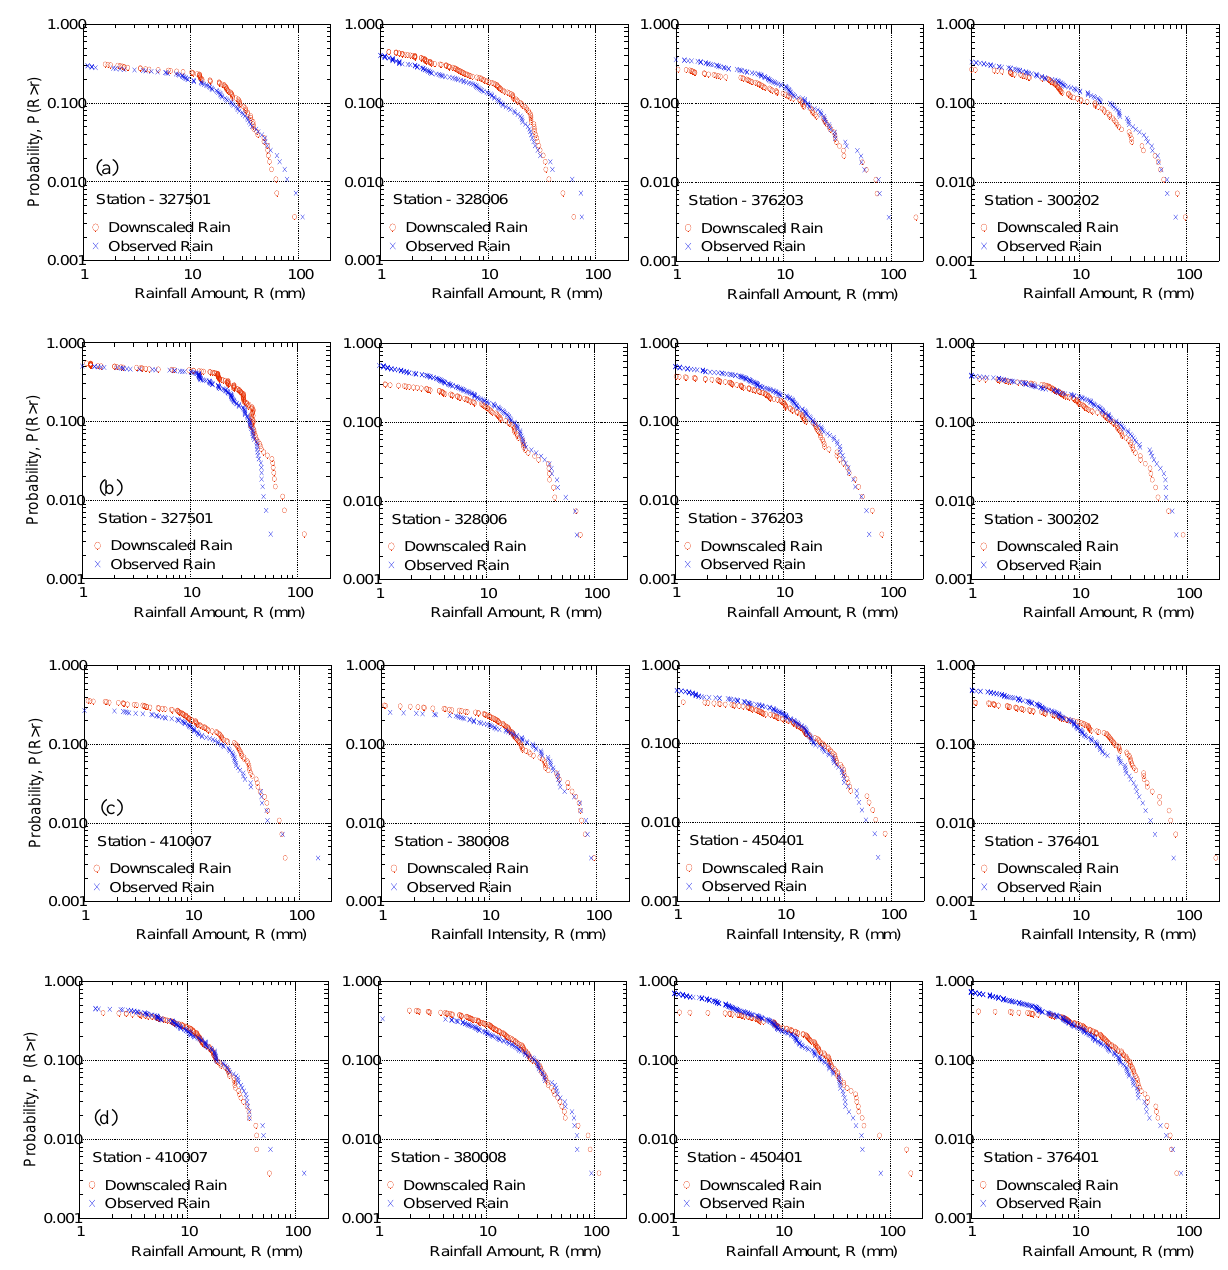
Fig. 10. Exceedance probability curve of rainfall amount at four rainfall stations from observed and downscaled data (a) grid 1-May, (b) grid 1-September, (c) grid 2-May, and (d) grid 2-September.